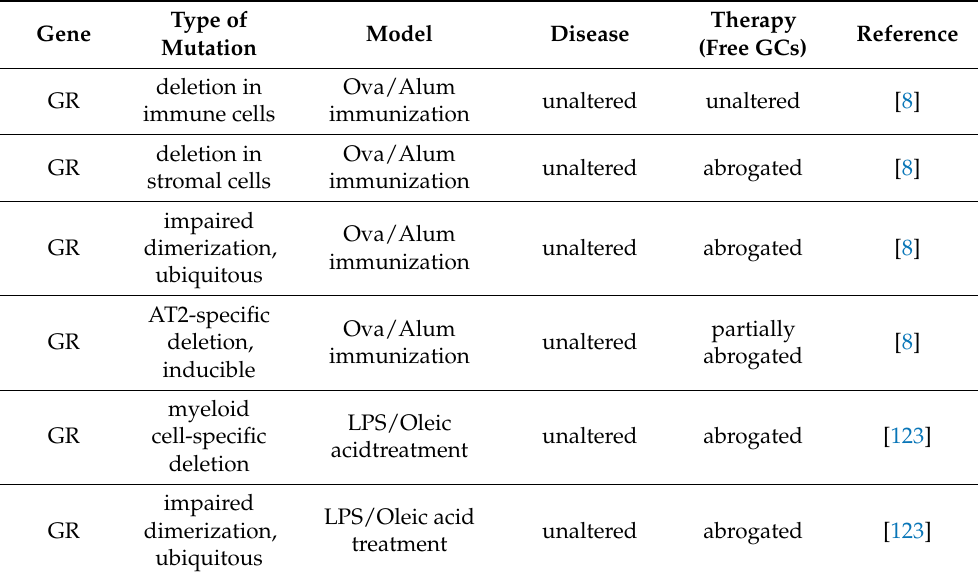
Table 3. Phenotype of selected genetic mouse models of pulmonary diseases. Ova/Alum immuniza- tion: allergic airway inflammation induced by immunization with ovalbumin adsorped to aluminum hydroxide. LPS/Oleic acid treatment: chemically induced model of ALI. Type of Gene Mutation